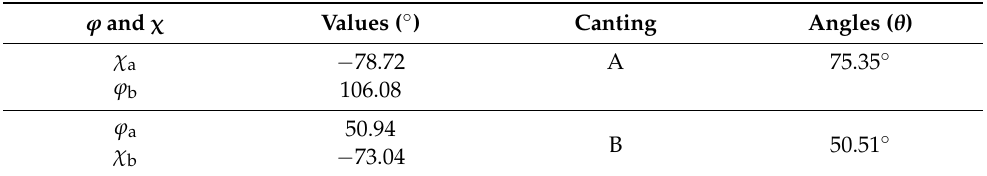
Figure 6. ( a ) Top view of the asymmetrical cone-1,2,4-out conformation of the host 3 in the ( endo-chiral )- 2 + @ 3 complex as obtained by DFT calculations (see Figure 4d). A and B capital letters in ( a ) indicate the aromatic rings of the DFT-optimized structure of 3 in the ( endo-chiral )- 2 + @ 3 complex, considered for the measurements of the canting angles θ , as defined in ( b ) (see Table 2). ( c ) ArCH 2 Ar ϕ and χ dihedral angles. Table 2. ϕ and χ ArCH 2 Ar dihedral angles adjacent to the aromatic rings A and B (see Figure 6) of 3 and canting angles values of the A and B rings of 3 a .